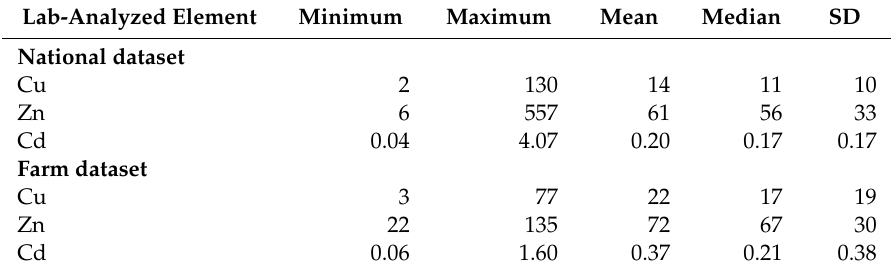
Table 3. Descriptive statistics of lab-analyzed copper (Cu), zinc (Zn), and cadmium (Cd) for the calibration data (national dataset, n = 1520) and validation data (farm dataset, n = 179). Minimum, maximum, mean, median, and standard deviation (SD) are presented as mg kg − 1 rounded to the closest integer, apart from those for